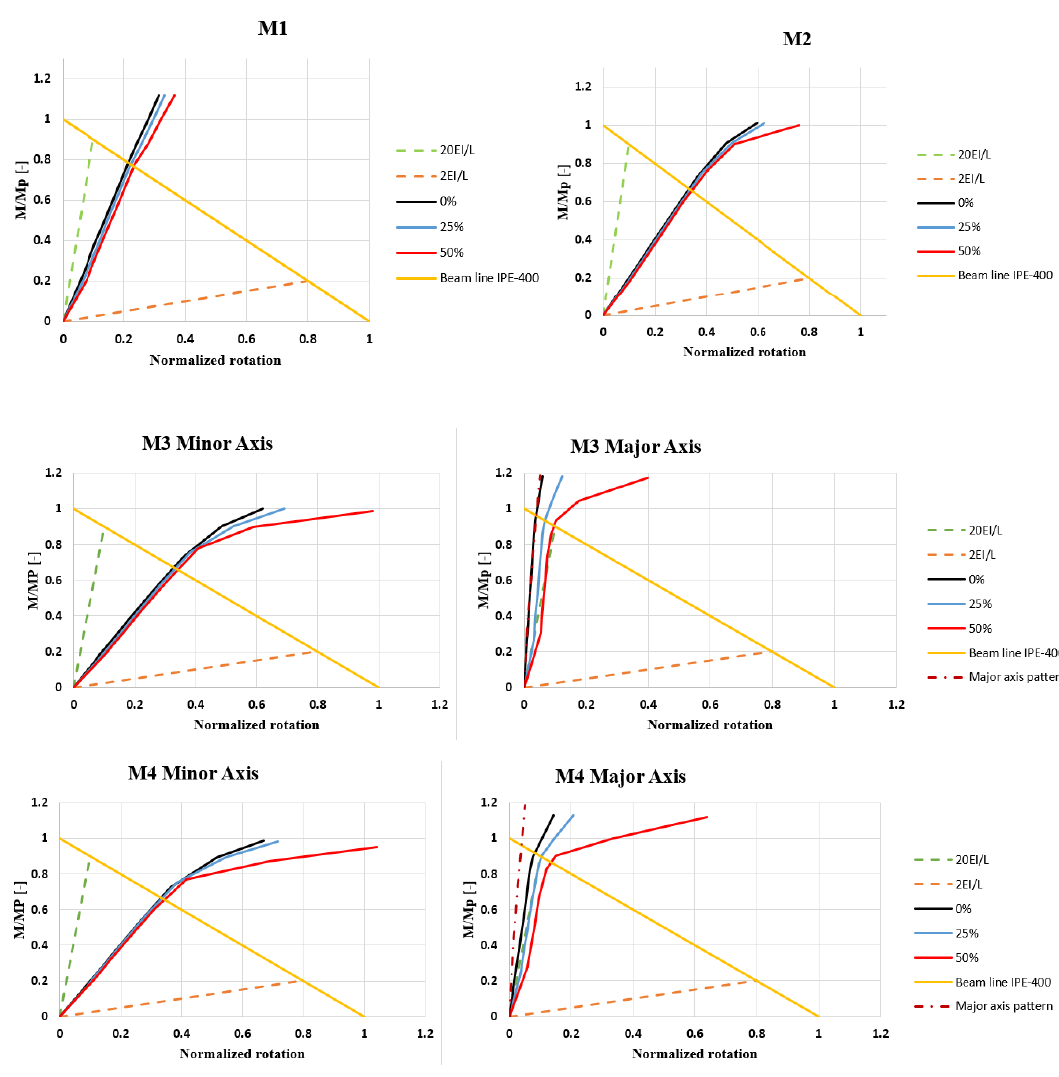
Figure 11. Normalized moment-rotation curves, elastic stiffness and comparison with limits established in AISC-360 Specification, data from [22], at each east beam.